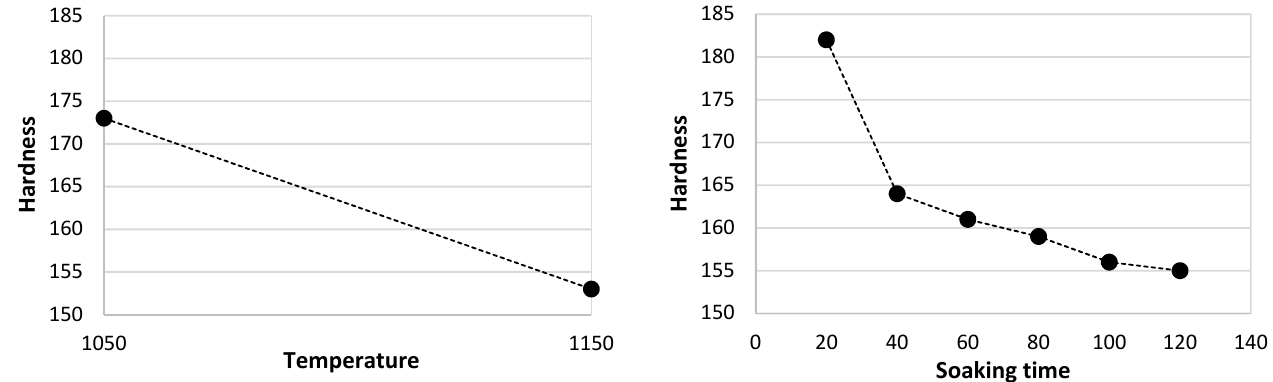
Figure 15. Effects of different test parameters and interactions, computed using Minitab software.